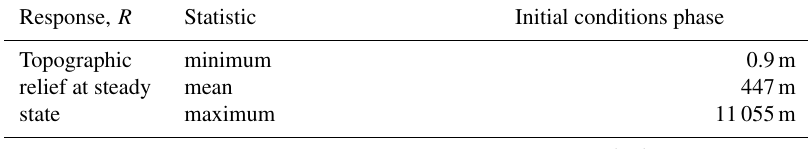
Table 2. Response summary statistics. The perturb-phase statistics are calculated separately for the trials when a given response, R , was less than, equal to, or greater than 0. Mean values of R were calculated for the trials in which R was not equal to 0. The plus–minus values associated with the mean R values provide the standard deviation of change for all model trials of a scenario in which R was not equal to 0.